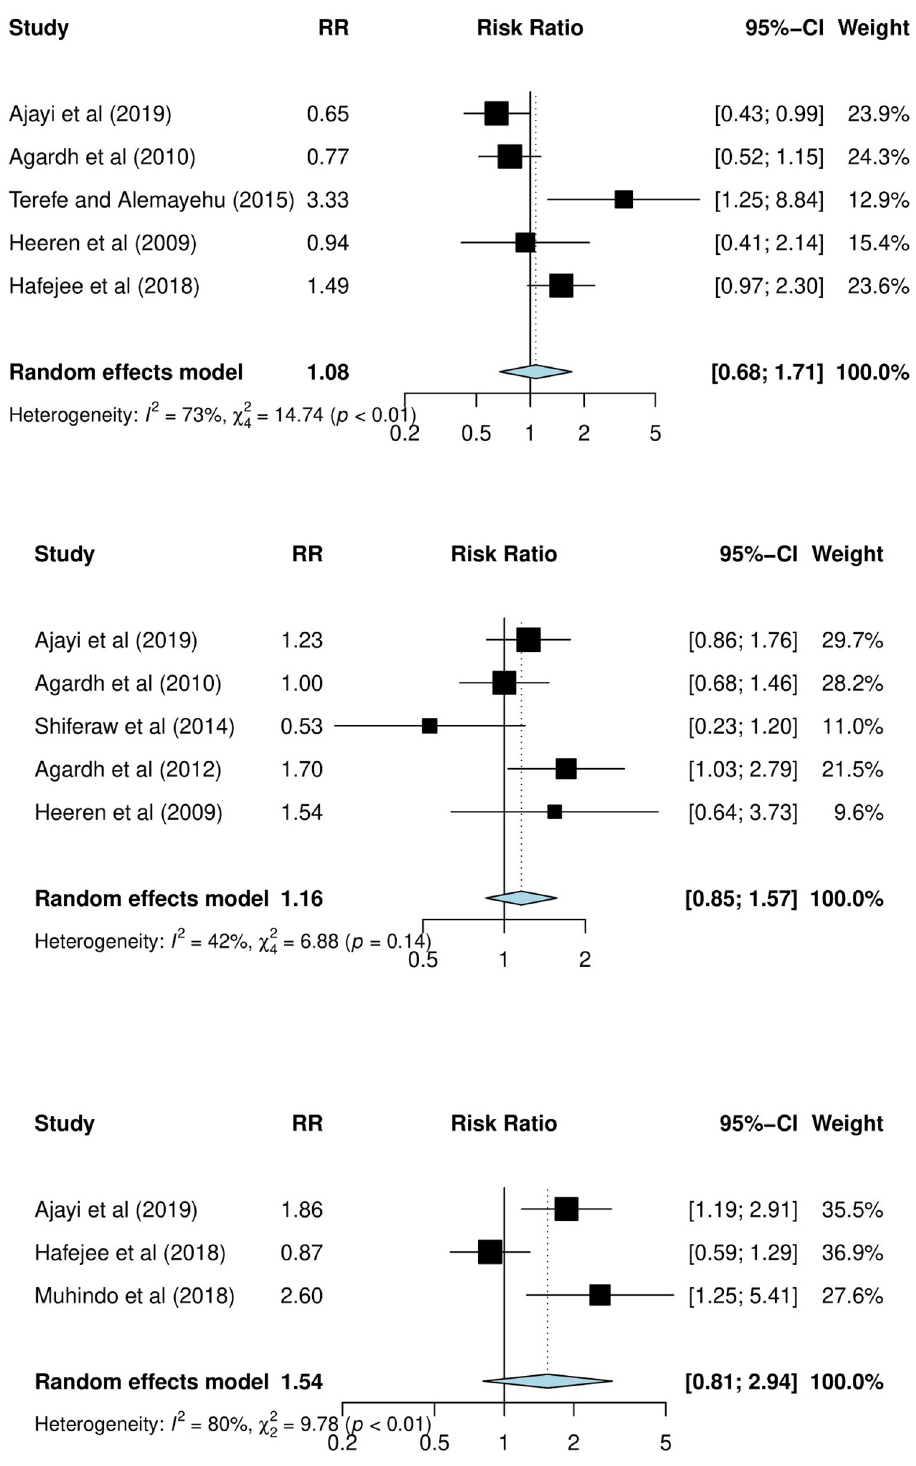
Fig 3. Panel of three forest plots showing the pooled association between sex, age, and condom negotiation efficacy with condom use at the LSI among university students in SSA. Fig 3A shows condom use at the LSI among female versus male students. Fig 3B shows condom use at the LSI among younger ( � 24 years old) versus older students (25 years and more). Fig 3C shows the condom use at LSI among students with a high versus low condom negotiation.